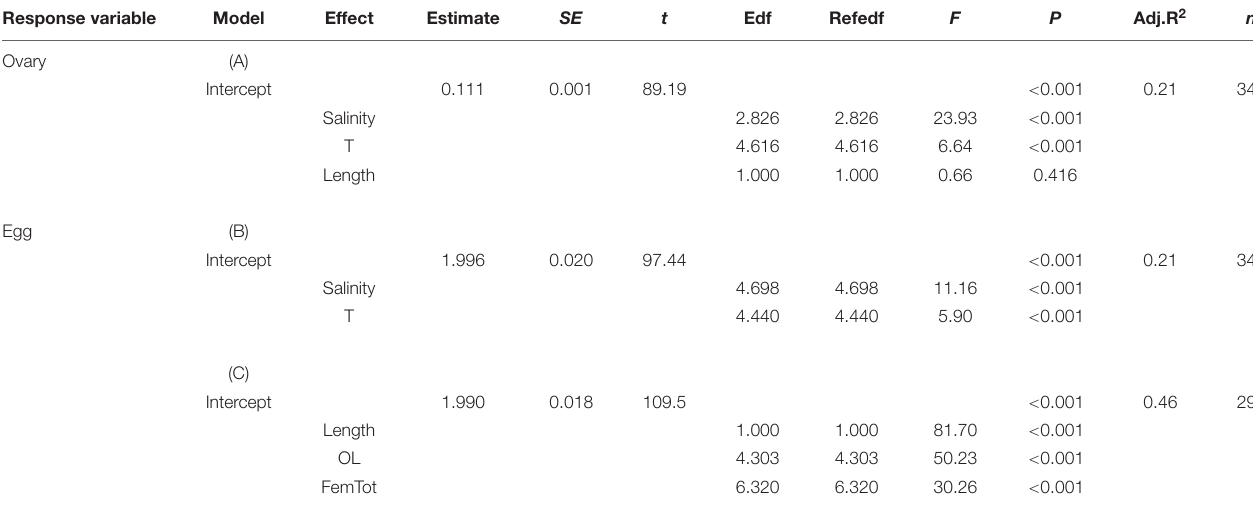
TABLE 1 | Parameter estimates from the Generalized Additive Mixed-effect Model analyzing the effect of salinity, winter temperature (T) and female length on the concentration of lipids in the ovary (% WW) of the Baltic herring in 1988–2019 ( = Model A), and the effect of the abiotic factors ( = Model B) and female traits ( = Model C) on the lipid content of eggs.